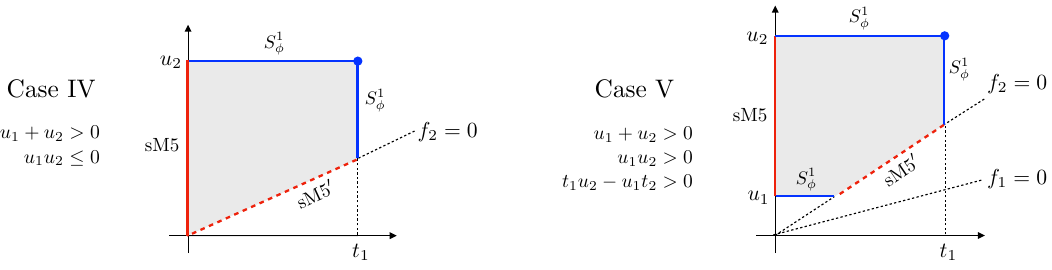
Figure 2. Non-rectangular domains arising from the inequalities (2.21) option (a), under the assumptions 0 < t and u . The label S 1 indicates that the φ circle in the base of the 1 ≤ t 2 1 < u 2 φ Dz fibration (3.2) shrinks smoothly along that component of the boundary of the allowed region. The labels sM5 and sM5 0 stand for two different kinds of smeared M5-brane